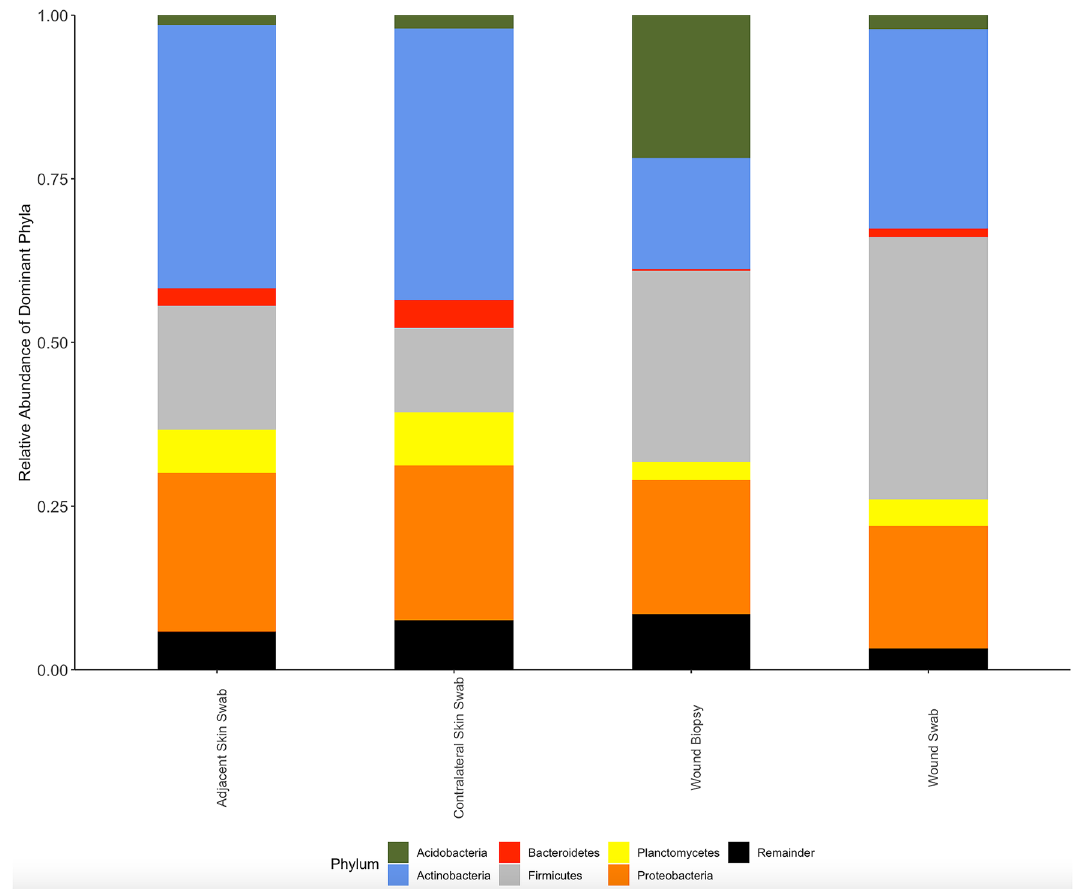
Figure 2. Relative abundance of the phyla in adjacent skin swabs, contralateral skin swabs, wound biopsies, and wound swabs. (Figure generated by R Studio version 1.3.1093 available at http:// www. rstud io. com/. Using R version 4.0.3 available at https:// www.R- proje ct. (FFPE-gram) and scanning electron microscopy (SEM) imaging. For the FFPE-FISH section, a CY3 tagged EUB probe was used to stain bacteria red, Concavalin A conjugated Alexa Fluor 488 marked the extracellular polymeric substances in green and DAPI marked the nuclei in blue. For the FFPE-Gram section, bacteria were Gram-stained, and the extracellular polymeric substances was stained orange by Safranin. SEM imaging allowed visualization of both cocci and bacilli (Supplementary Fig. 1). Wound biopsies of the 39 cutaneous leishmaniases confirmed (by PCR) lesions of patients were visualized for bacterial biofilms. Of them, 24 (61.5%) lesions were positive for biofilms by FFPE-FISH. By SEM, 23 out of the 39 lesions (59.0%) were biofilm positive. One sample which was biofilm positive by FFPE-FISH was found to be biofilm negative using SEM. FFPE-Gram detected 14 (35.9%) lesions as biofilm positive. Fourteen samples were confirmed as biofilm positive and 15 were biofilm negative by all three imaging techniques and 10 were positive at least by one method. The mean size of the biofilms in these cutaneous leishmaniasis lesions was 47.9 µm (SD +/− 32.9, range = 6.8–141.7). There were 2 biofilm lesions 5–10 μm, 13 lesions 11–50 μm, and 9 lesions > 50 μm in size. FFPE-FISH, FFPE-Gram and SEM images of cutaneous leishmaniasis wounds are shown in Supplementary Fig. 2, 3a and 3b-c respectively. In some samples, identification of the bacterial red signal by FFPE-FISH was hindered by auto-fluorescent granules of the skin and the extracellular polymeric substances was less (or not) evident. In the FFPE-Gram sections, most of the biofilm positive samples had gram-positive cocci bacterial aggregates. Isolated small aggregates of bacteria were apparent in most of the slides. However, in most of the chains, or both, and the extracellular substance could be demonstrable. Different textures of the extracellular substance could be seen by SEM i.e., smooth, and thin thread-like. The association of bacterial biofilms in cutaneous leishmaniasis wounds with clinico‑demographic characteristics of the study cohort. The association between the presence of biofilm in CL lesions and relevant clinico-demo- graphic variables are summarized in Supplementary Table 2.